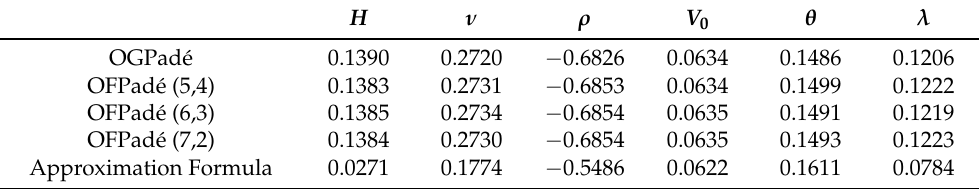
Figure 1. Implied volatility surface calibration on the SPX implied volatility (18 June 2021—dashed red line) for the OGPadé (diamond marker), OFPadé approximants ( 5,4 ) , ( 6,3 ) , ( 7,2 ) (square, cross, circle marker), and approximation formula (asterisk marker). Table 2. Calibration to SPX implied volatility on 12 September 2008.